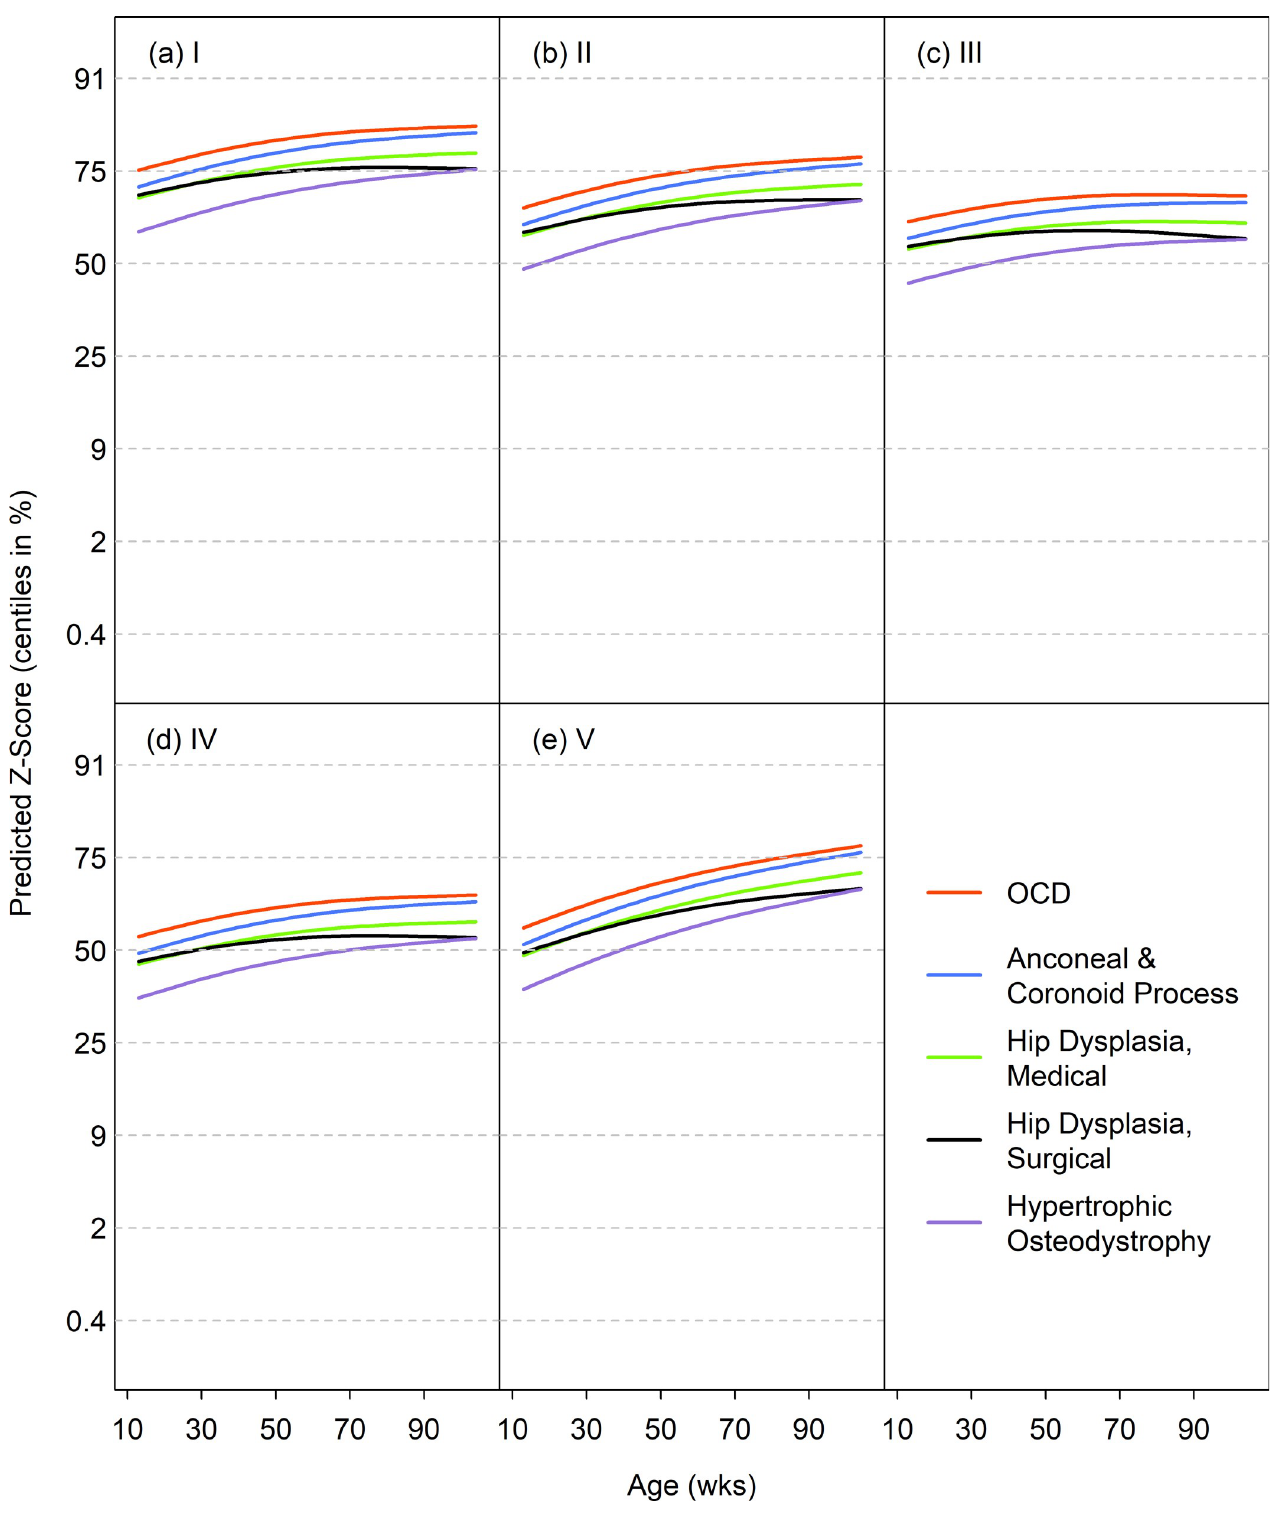
Fig 7. Median weight curves (on the centile scale) for diseases associated with accelerated growth in 5 size classes. Diseases are OCD (red), ‘anconeal & coronoid process’ (blue), ‘hip dysplasia, medical’ (green), ‘hip dysplasia, surgical’ (black) and hypertrophic osteodystrophy (purple).